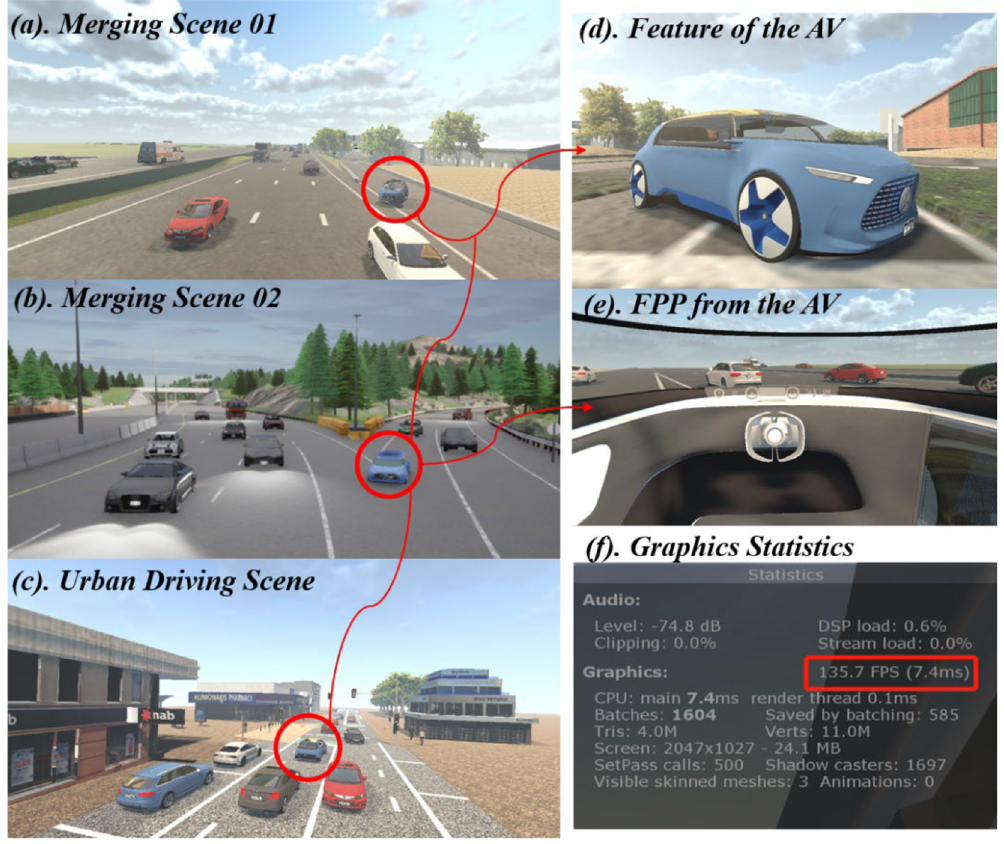
Figure 2 Details of the VR environments